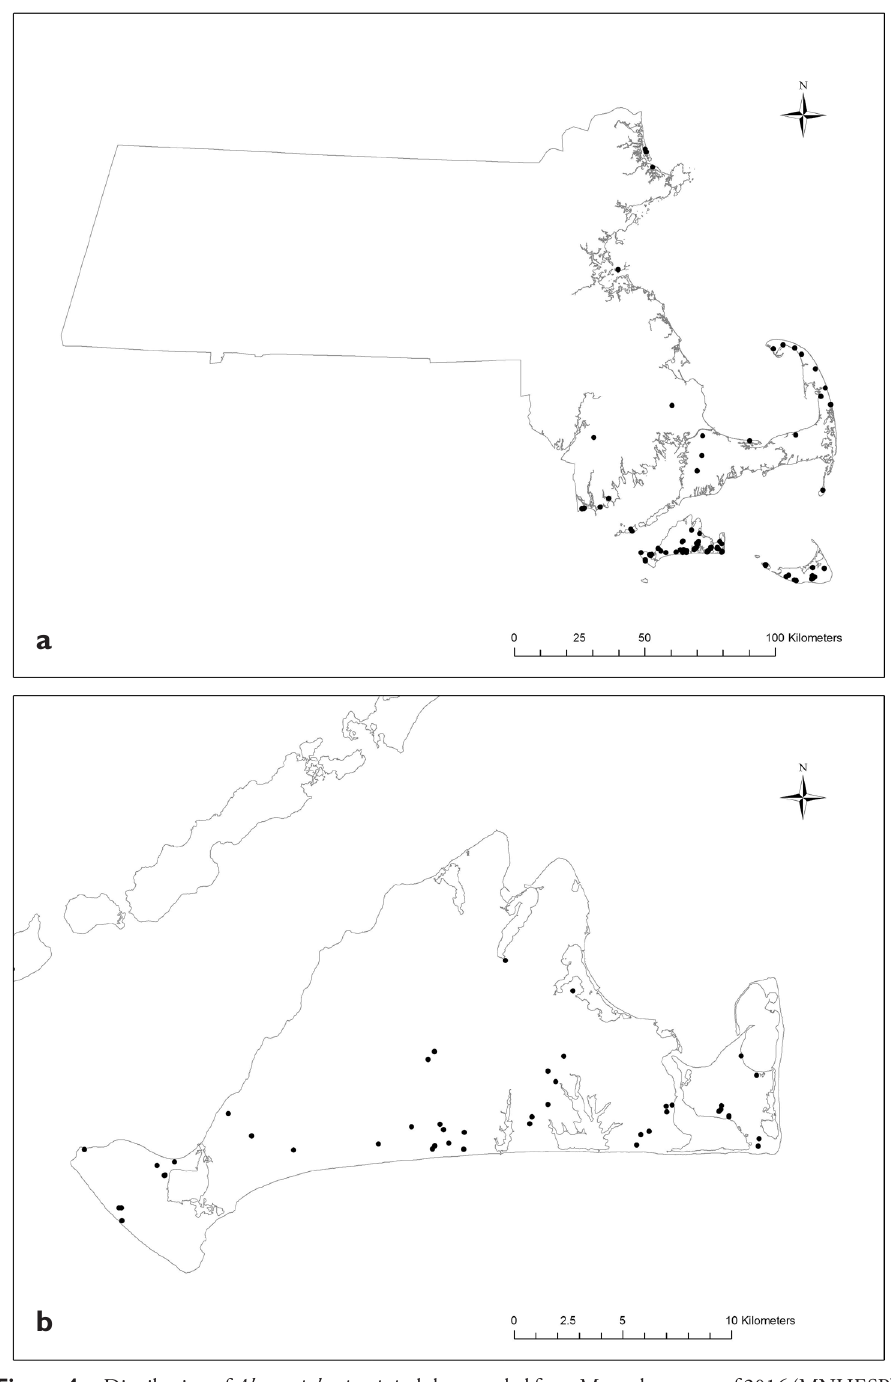
Figure 4. a Distribution of Abagrotis benjamini adults recorded from Massachusetts as of 2016 (MNHESP), b Distribution of Abagrotis benjamini adults recorded from Martha’s Vineyard as of 2016